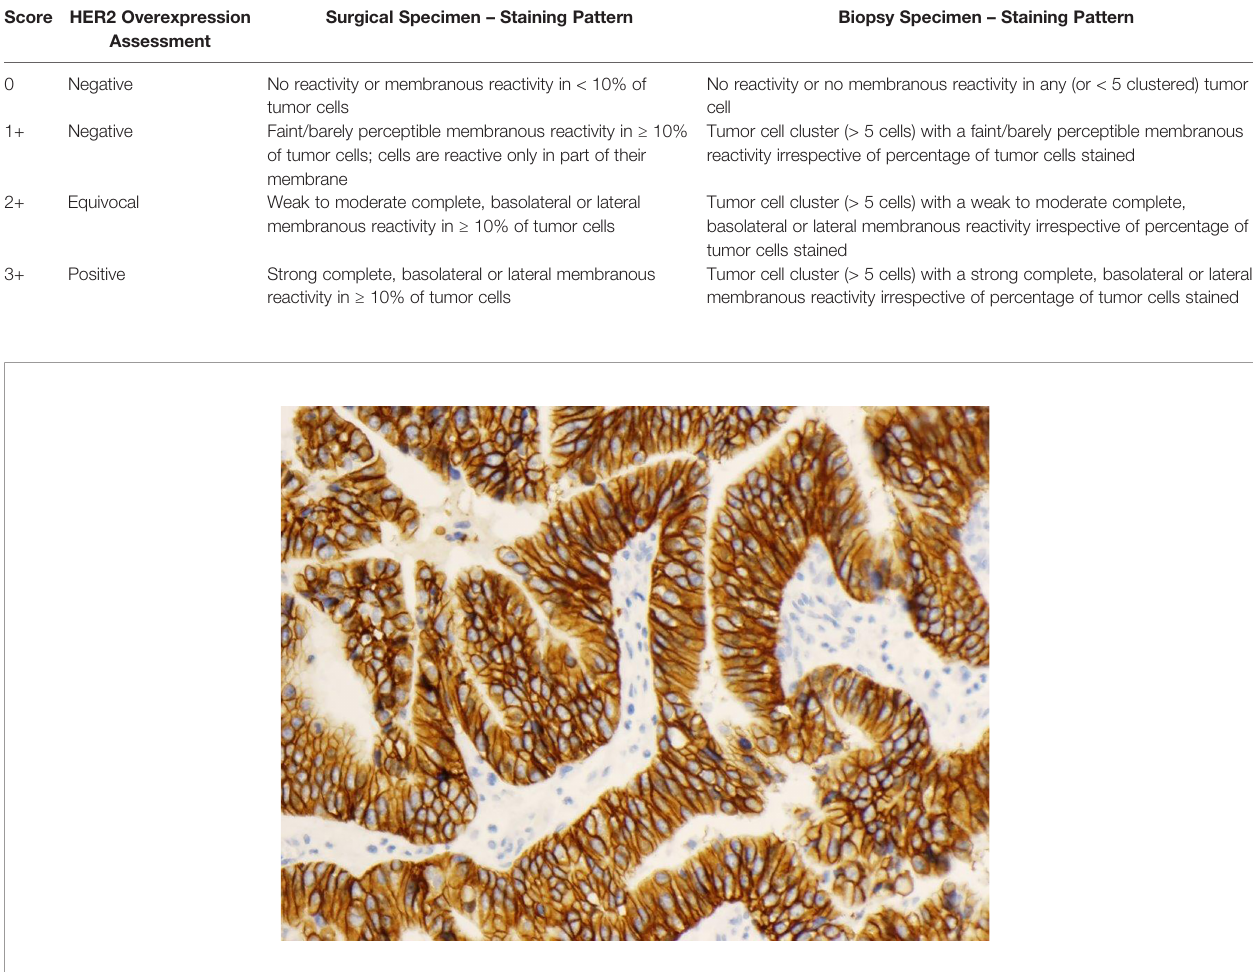
FIGURE 3 | Adenocarcinoma of the stomach stained with HercepTest ™ , IHC3+